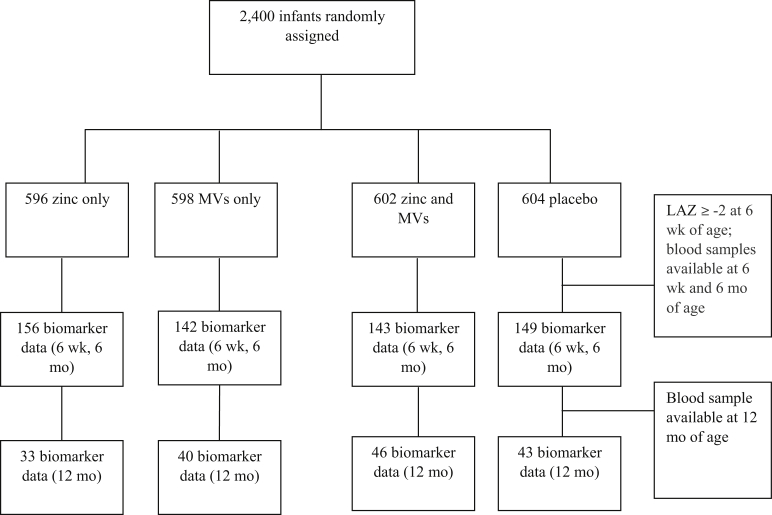
Flowchart of study enrollment and follow-up evaluation. LAZ, length-for-age z score.